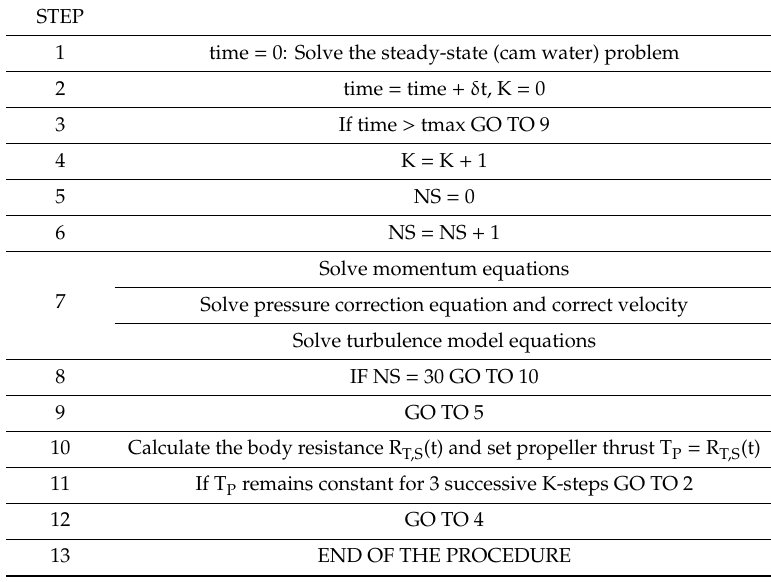
Table 1. The general algorithm.